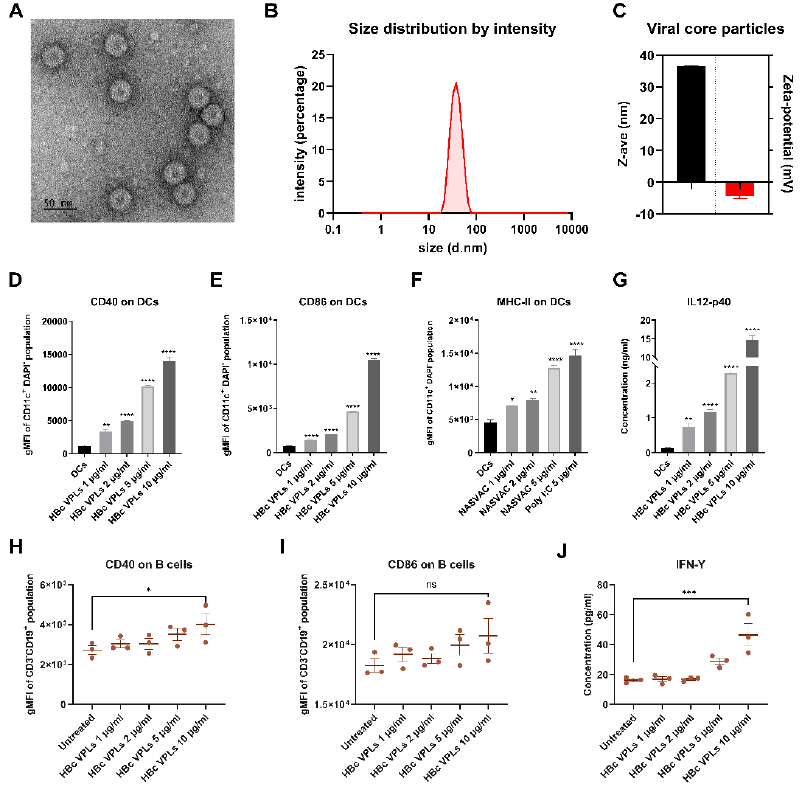
Figure 4. Physicochemical and biological activity of HBc VLPs in vitro. ( A ) Representative TEM image of HBc VLPs (scale bar 50 nm). ( B ) Representative histogram for the size of the viral core particle. ( C ) The average size (z-ave) and zeta potential of the HBc VLPs. ( D – G ) In vitro DCs activation assay after 24 h of incubation with viral core particles. The gMFI of CD40 ( D ), CD86 ( E ), and MHC-II ( F ) on DCs (CD11c + DAPI − cells) and IL12-p40 secretion ( G ) in the supernatant were compared to the untreated DCs control group. ( H – J ) In vitro B cell activation assay using splenocytes from tumor-bearing mice (n = 3) after 24 h of incubation with viral core particles. The gMFI of CD40 ( H ) and CD86 ( I ) on CD45 + CD19 + CD3 − cells and IFN- γ expression ( J ) the supernatant was compared to untreated control splenocytes. All graphs show the mean values ± SEM from three independent experiments. Statistical analysis was performed using a one-way ANOVA (the statistical differences are denoted as ns: non-significantly, * p < 0.05, ** p < 0.01, *** p < 0.001, and **** p <